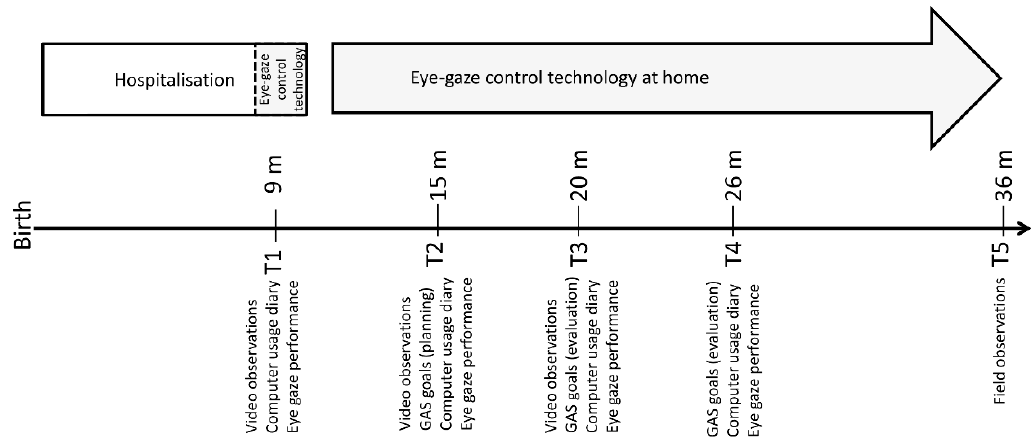
Figure 1. Timeline with data collection at T1–T5. The first attempts to use eye-gaze control technology occurred during hospitalization.